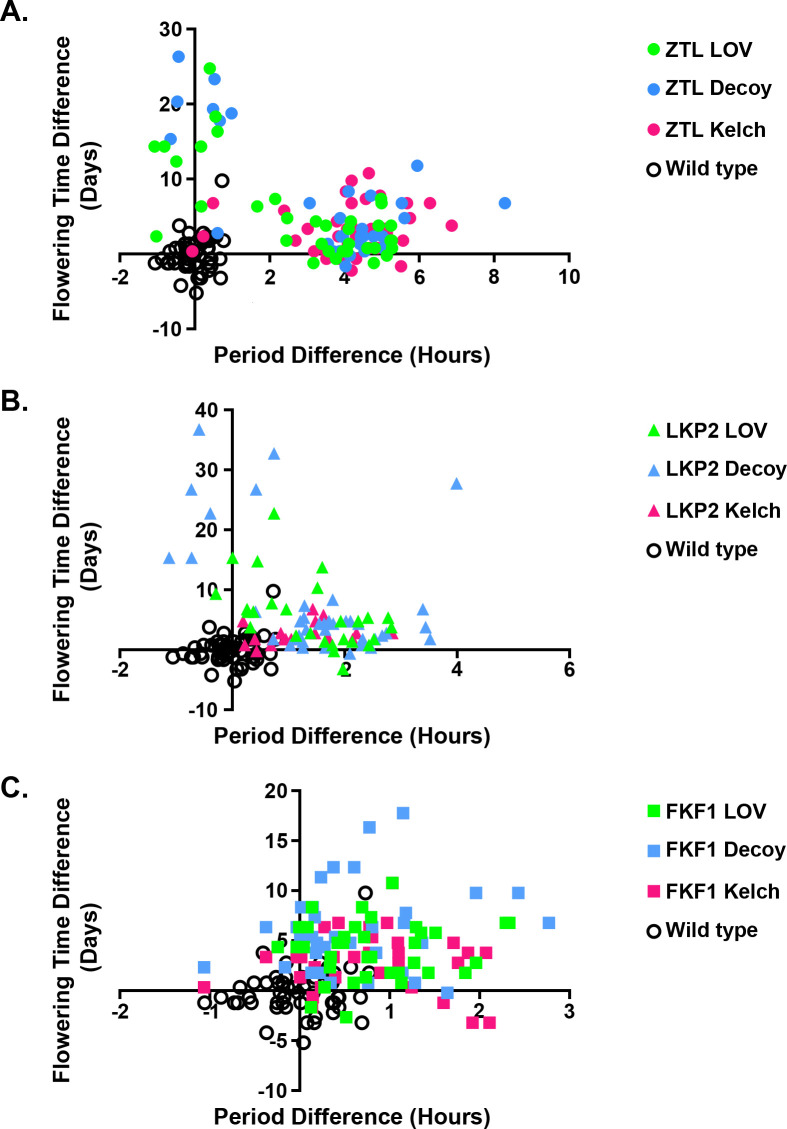
Period and flowering time are anti-correlated in the ZTL LOV, ZTL decoy, LKP2 LOV, and LKP2 decoy overexpressing plants.Data from Fig 1 was replotted to present flowering time as a function of period for every T1 insertion plant and the CCA1p::Luciferase (wild type) control. A) Plants expressing domains of ZTL (circles); B) plants expressing domains of LKP2 (triangles); C) plants expressing domains of FKF1 (squares). Blue shapes: plants expressing the decoy (LOV-Kelch); Green shapes: plants expressing the LOV domain; Pink shapes: plants expressing the Kelch repeat domain; open circles: wild type plants. Note that the same wild type data is used in panels A-C.